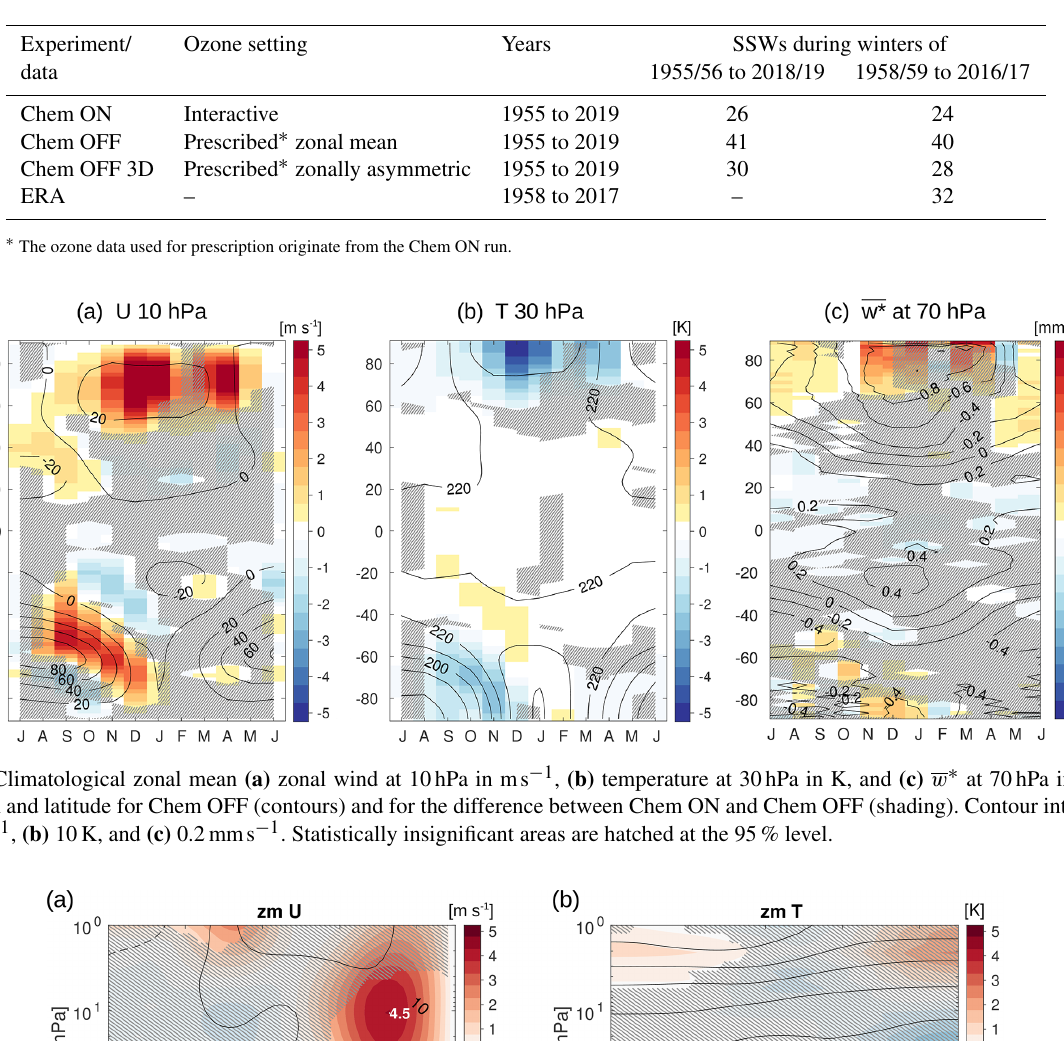
Table 1. Model experiments carried out with CESM1(WACCM) in Chem ON, Chem OFF, and Chem OFF 3D mode. For more details see text.